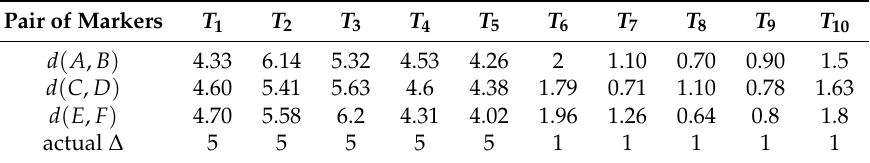
Table 1. Simulation of the crack opening: three pairs of markers (A and B, C and D, E and F) moving away from each other, in five steps by 5 mm ( T 1 , . . . , T 5 ) and 5 steps by 1 mm ( T 6 , . . . , T 10 ). All the distance values are expressed in mm. The distances were evaluated using two methods: (MM) as in [17]; (Rt) computing the 3D translation vectors directly from the camera pose parameters. The distances shown here were calculated using the MM method, and the camera was calibrated with a ChArUco